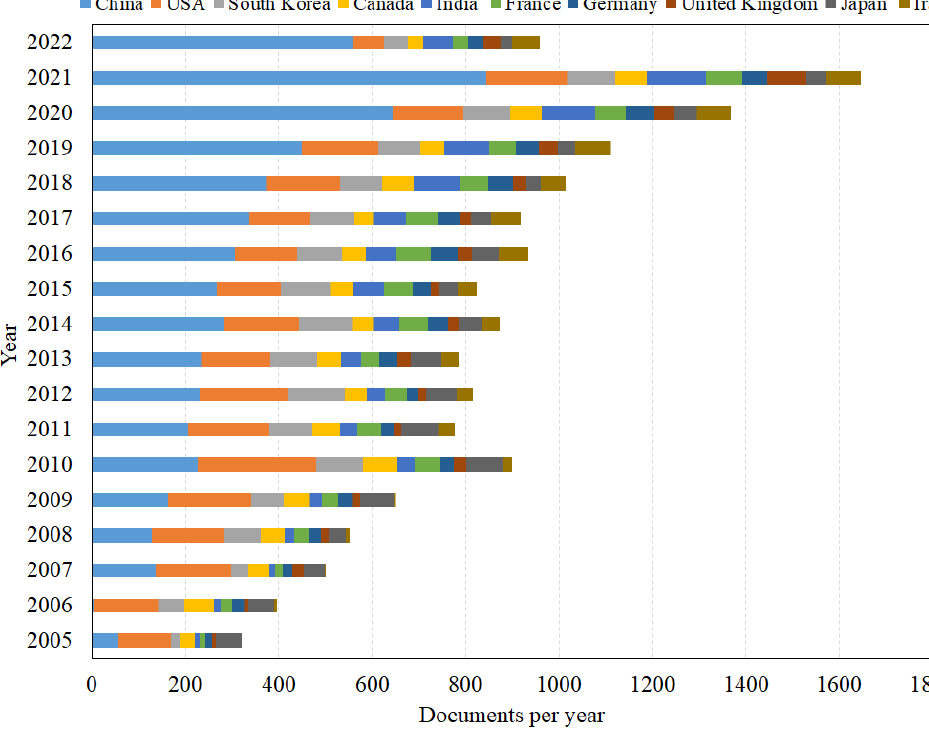
Figure 7. Trends of publications in top 10 countries.